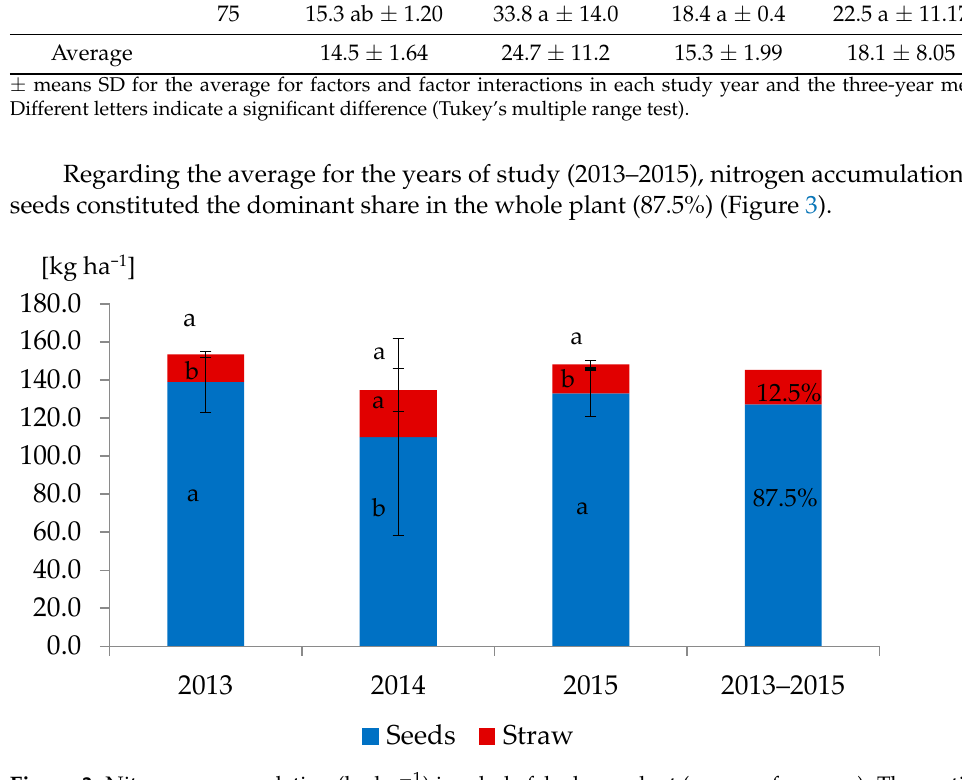
Figure 3. Nitrogen accumulation (kg ha − 1 ) in whole faba bean plant (average for years). The vertical line atop bar is SD for that mean. Different letters indicate a significant difference (Tukey’s multiple range test).